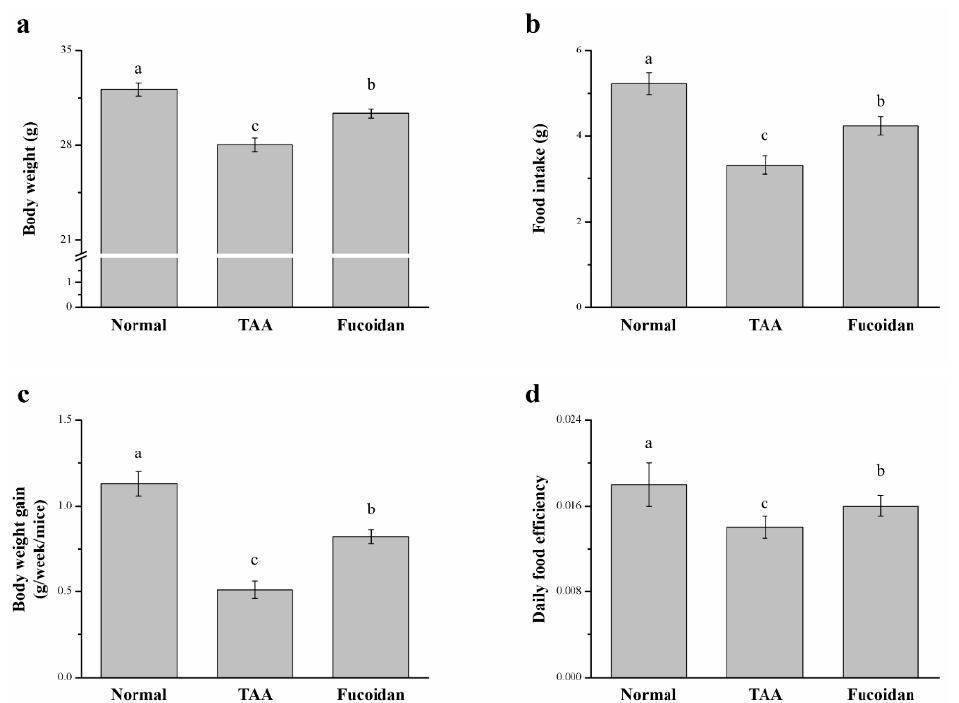
Figure 1. Changes of the ( a ) body weight, ( b ) food intake, ( c ) weekly body weight gain, and ( d ) daily food efficiency in normal mice, mice with thioacetamide (TAA)-induced liver injury, and fucoidan-treated mice with TAA-induced liver injury within a time period of 42 days. All data are presented as the means ± standard error (SEMs) ( n = 10). a–c Data with different letters in the columns are significantly different with one-way analysis of variance (ANOVA), and the means of different groups were compared by Duncan’s test at p < 0.05.